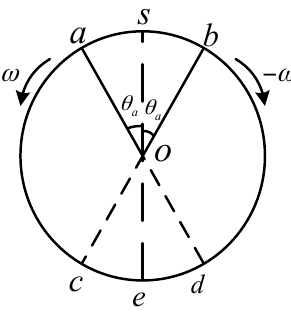
Figure 7. The rotation process in a reciprocating rotation cycle.